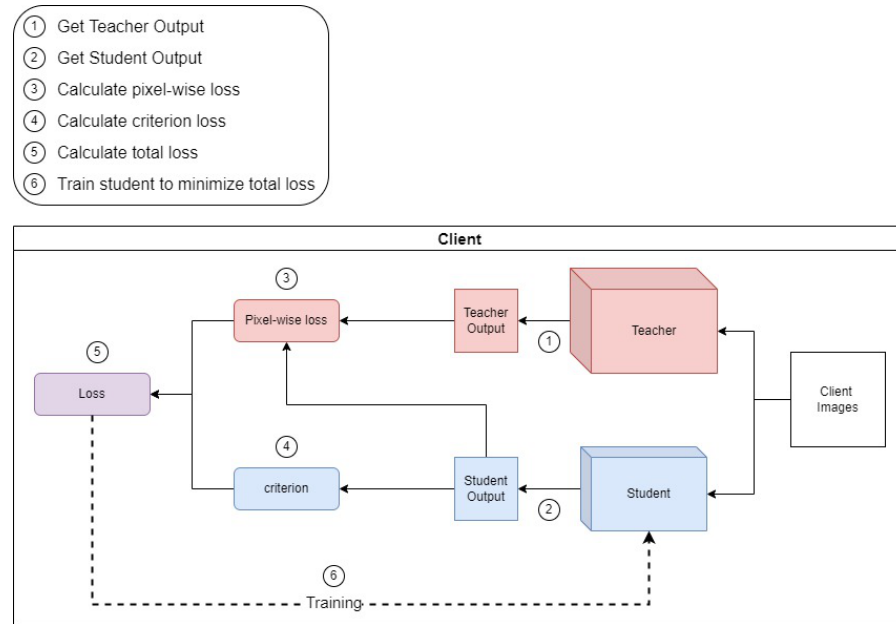
Figure 2. Teacher–student federated learning model